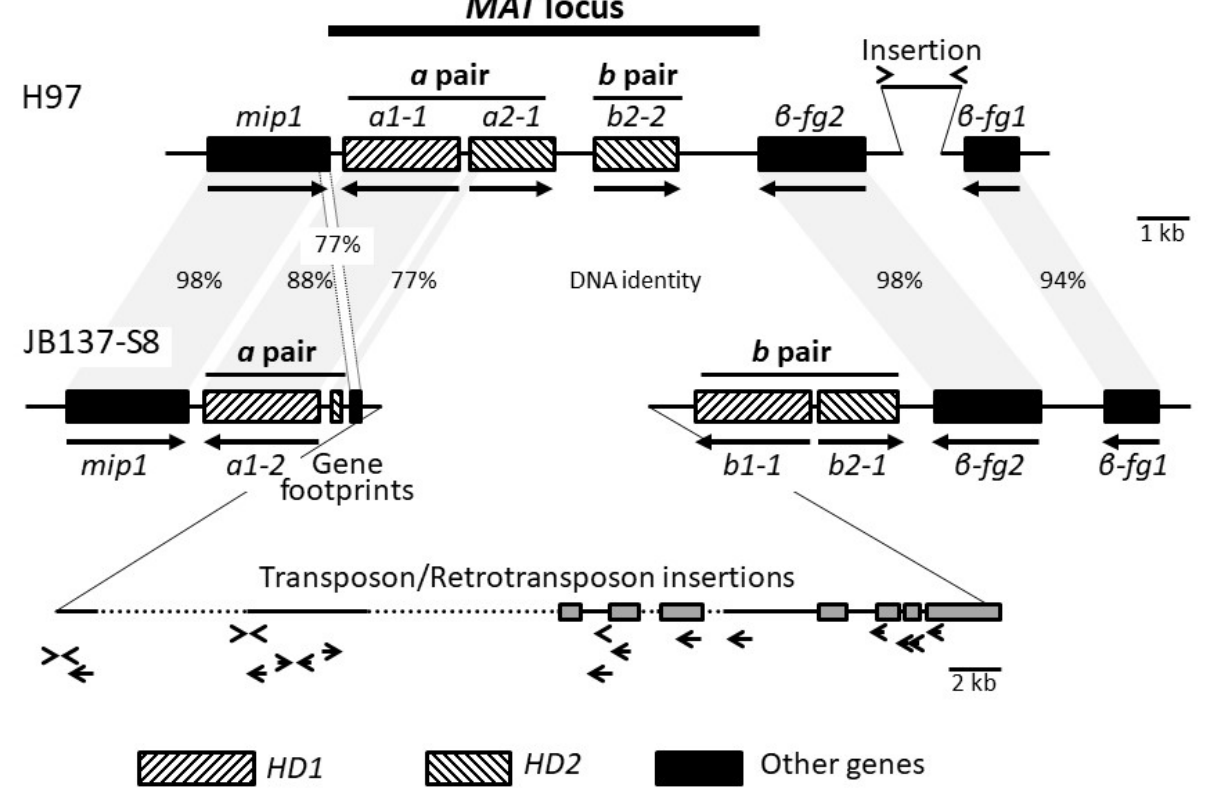
Figure 3. Comparison of the region with the MAT locus on chromosome 1 of A. bisporus var. bisporus H97 and A. bisporus var. burnettii JB137-S8. Shared genes are shown by black boxes, and HD1 and HD2 genes by boxes striped from bottom left to top right and from top left to bottom right, respectively. Closed arrows beneath genes indicate direction of transcription. Genes of DNA similarity or high identity between the two strains are marked with percentages of identity. Insertions are shown by the insets (note the different relative size of the inset in strain JB137-S8). Direct or inversely repeated sequences are marked by arrowheads, and grey boxes indicate DNA sequences that in blastx searches in the NCBI GenBank hit proteins with transposon/retrotransposon activities.